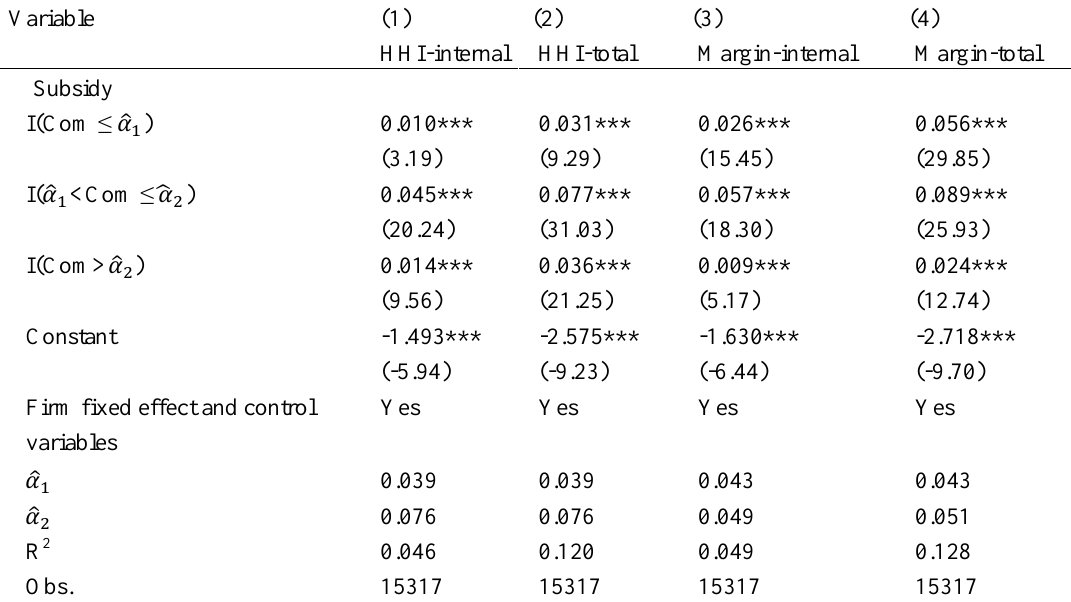
Table 4: The impact of industry competition on R&D subsidy effectiveness